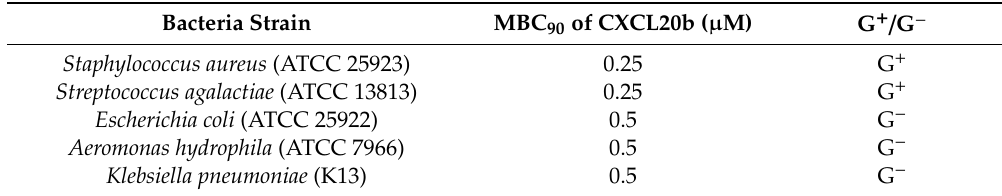
Figure 3. Antimicrobial activity of grass carp CXCL20b. The antimicrobial activity of grass carp CXCL20b was determined through CFU assays. Increasing concentrations of recombinant grass carp CXCL20b protein were incubated for 30 min with Gram-positive bacteria Staphylococcus aureus (ATCC 25923), S. agalactiae (ATCC 13813), Gram-negative bacteria Escherichia coli (ATCC 25922), Aeromonas hydrophila (ATCC 7966), and Klebsiella pneumoniae (K13). Data from three independent experiments are shown (mean ± SEM). Table 1. MBC 90 determination of grass carp CXCL20b antimicrobial activities against several microorganisms in 1 h.